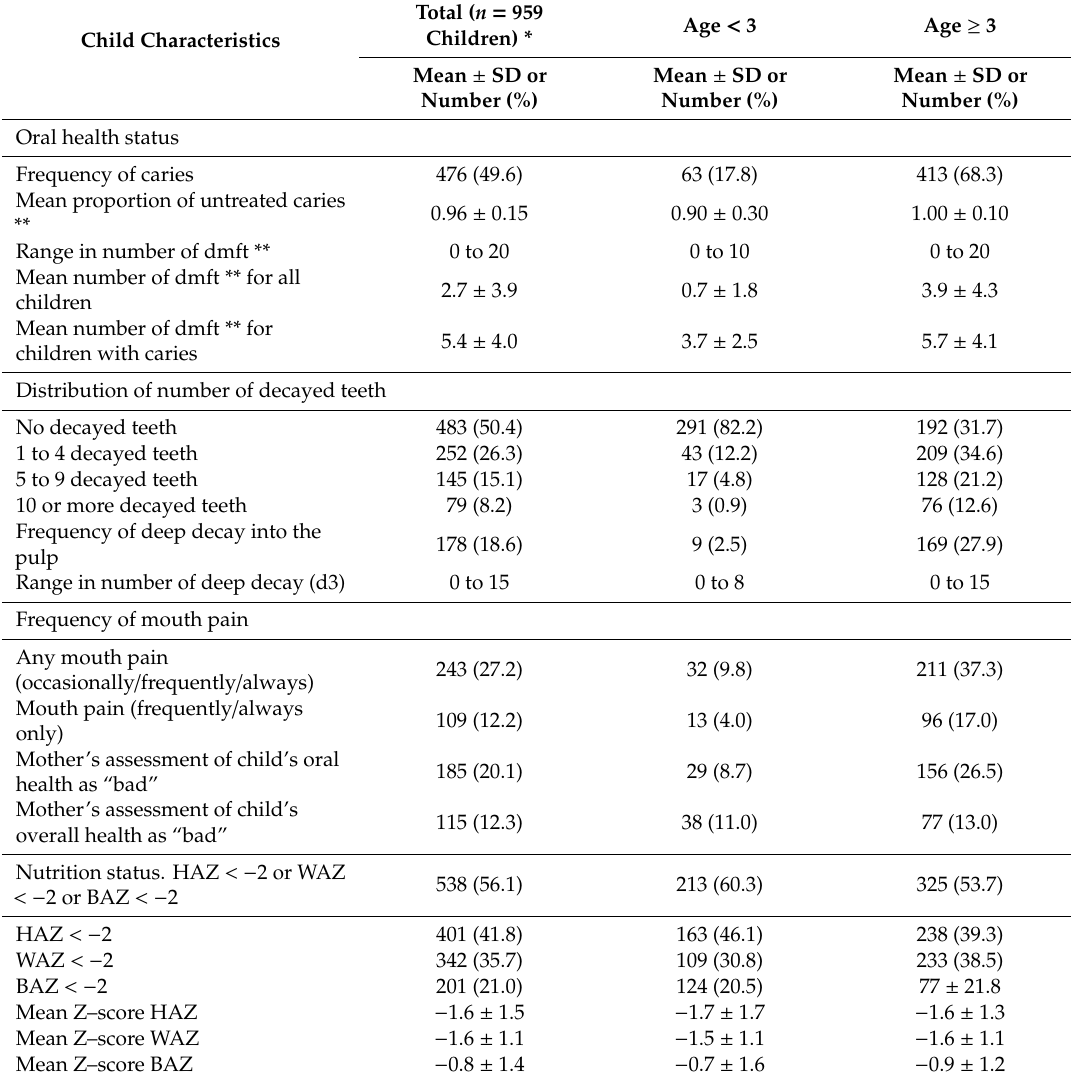
Table 4. Child Oral Health and Nutrition